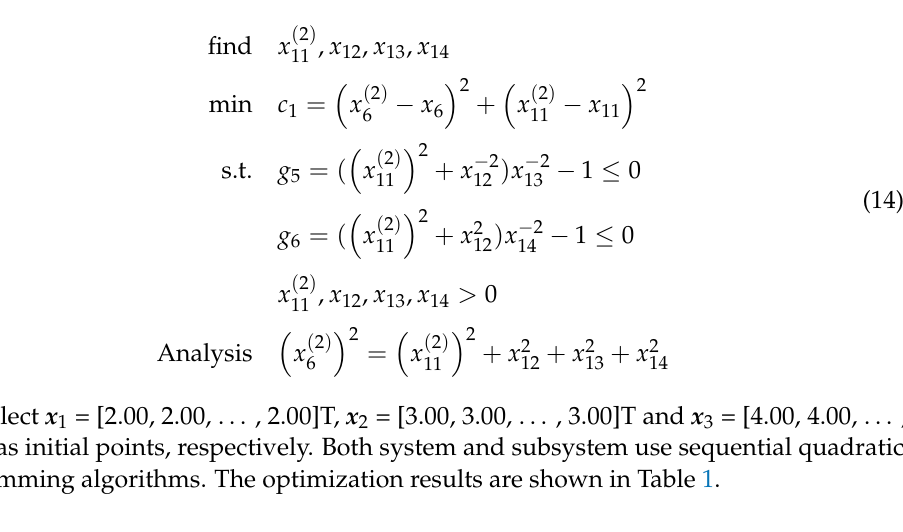
Table 1. The results of the CO. Initial Points